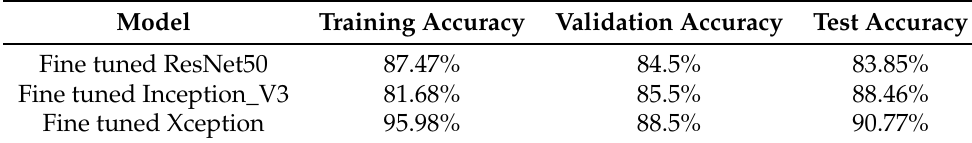
Table 7. Results of training deep learning models for image classification: